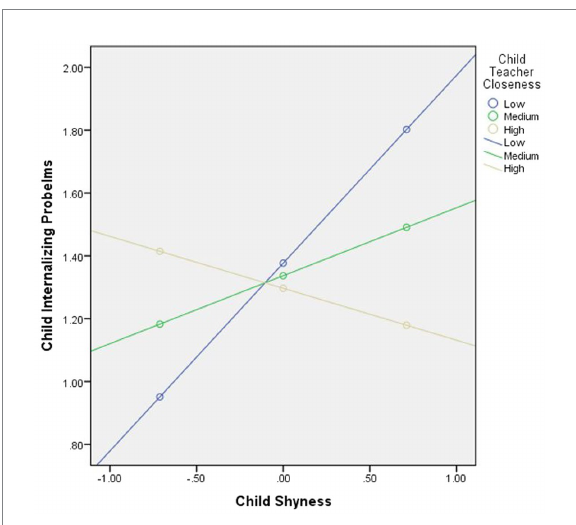
FIGURE 1 Interaction between child shyness and child-teacher closeness in predicting child internalizing